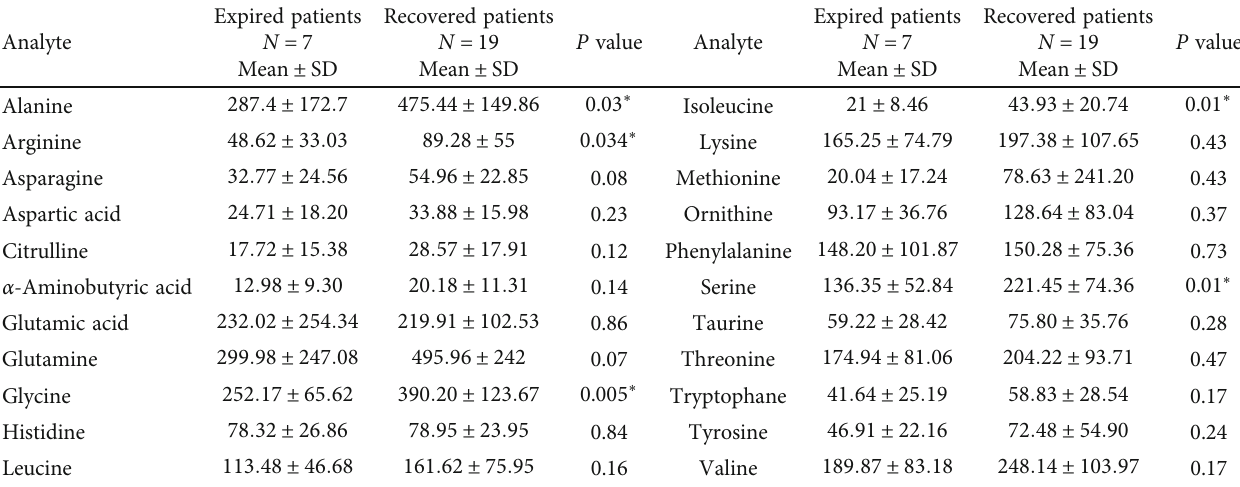
Table 4: Comparison of amino acids concentration ( μ mol /L) between the recovered and expired patients. Analyte